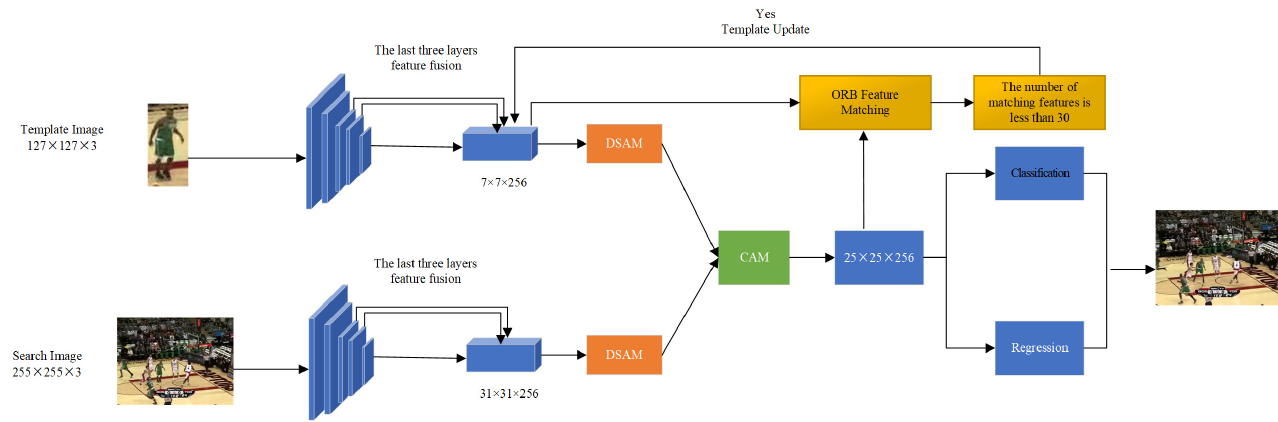
Figure 1. Architecture of our tracking framework.